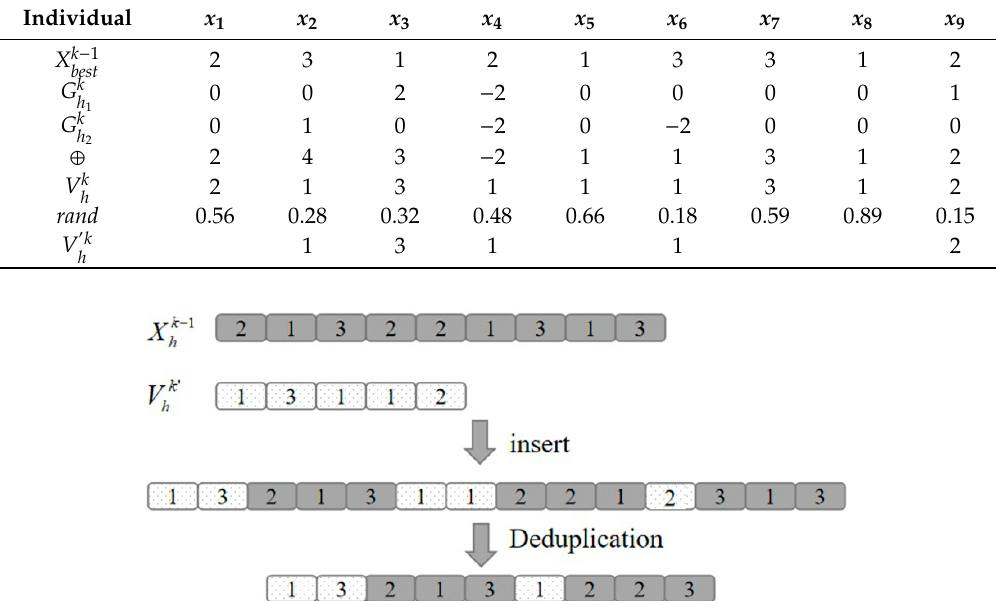
Table 5. Generation of trial individual ( Y = 0.5).